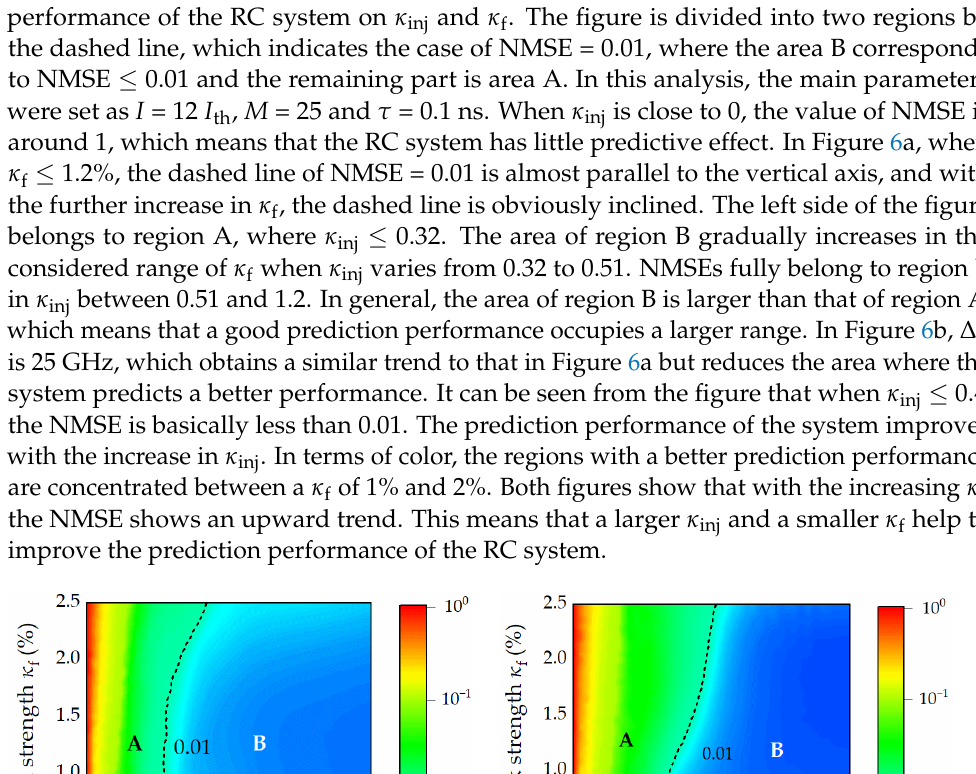
Figure 5. Two- dimensional maps of NMSEs in the parameter space of frequency detuning Δ ν and feedback strength κ f for ( a ) κ inj = 0.4; ( b ) κ inj = 0.8, with I = 12 I th and M = 25; the dashed line indicates NMSE = 0.01.